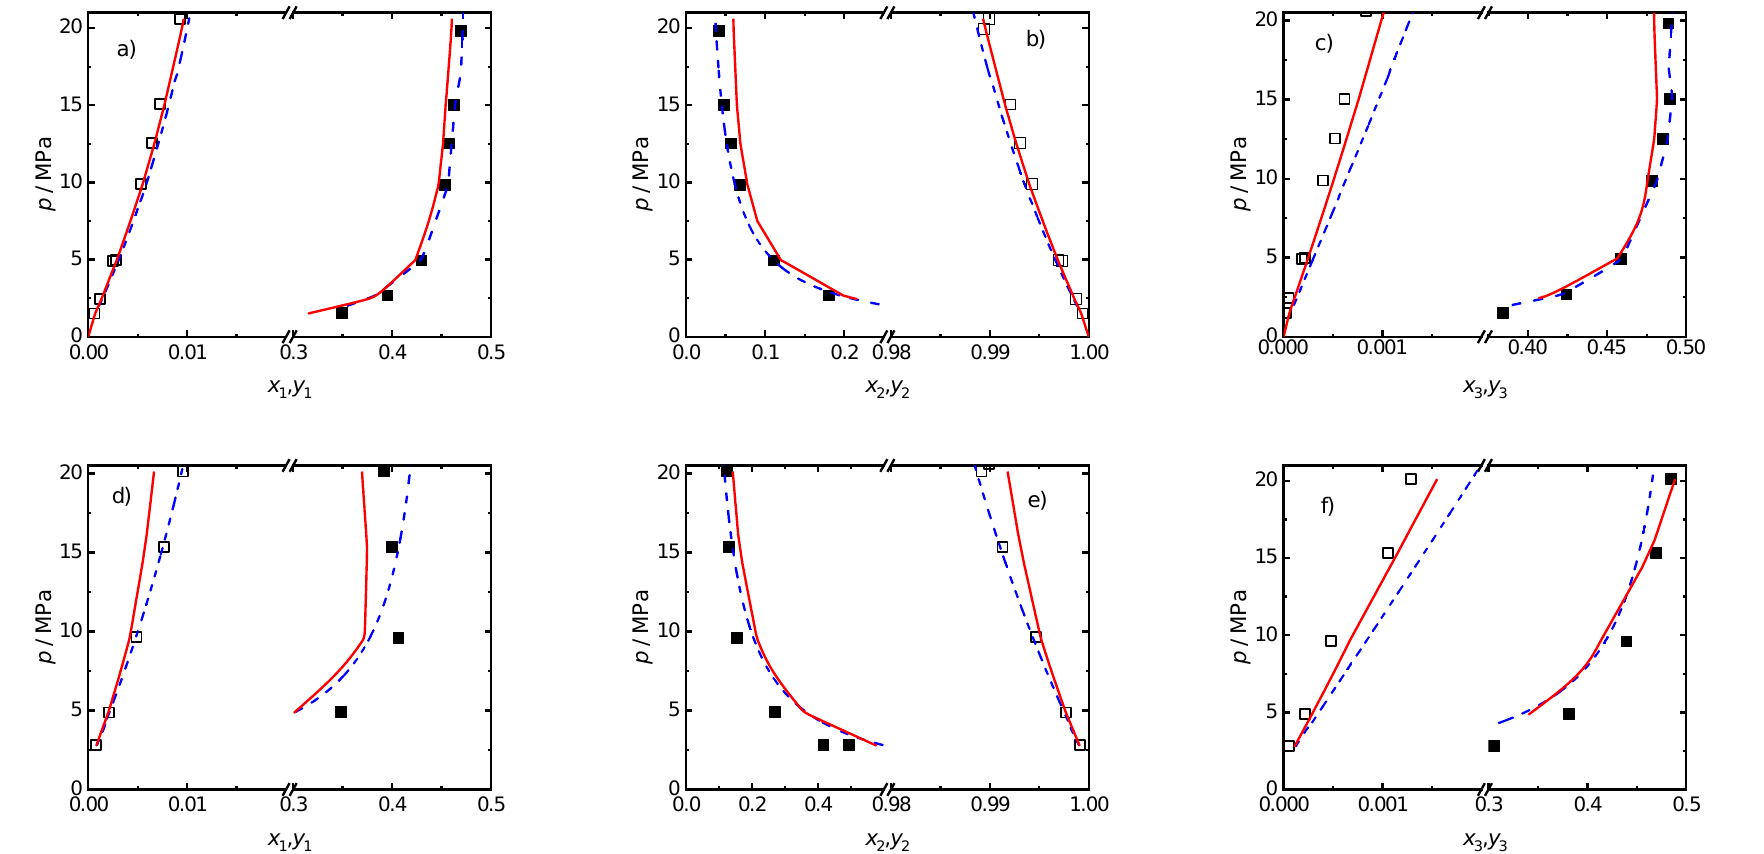
Figure 7. Vapour–liquid equilibrium for the (CO 2 (1) + H 2 O(2) +N 2 (3)) system at temperatures of ( a – c ) 423 K and ( d – f ) 473 K. Empty symbols represent dew points, and filled-in symbols represent bubble points. The mole ration of CO 2 /N 2 fed to the system was 1. Continuous red lines represent the description of the γ - ϕ model, and dashed blue lines represent the description of the SAFT- γ Mie model .